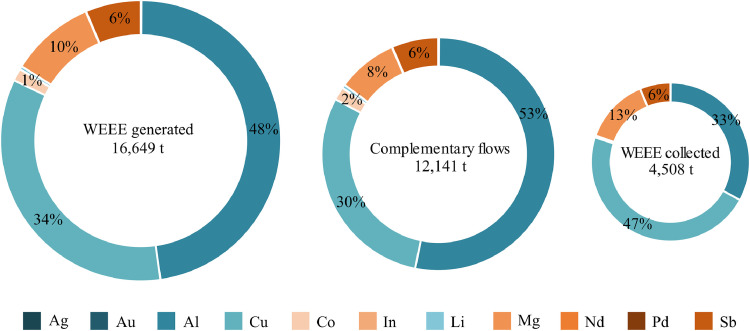
WEEE category II in France: total amount and target elements’ share (2017).